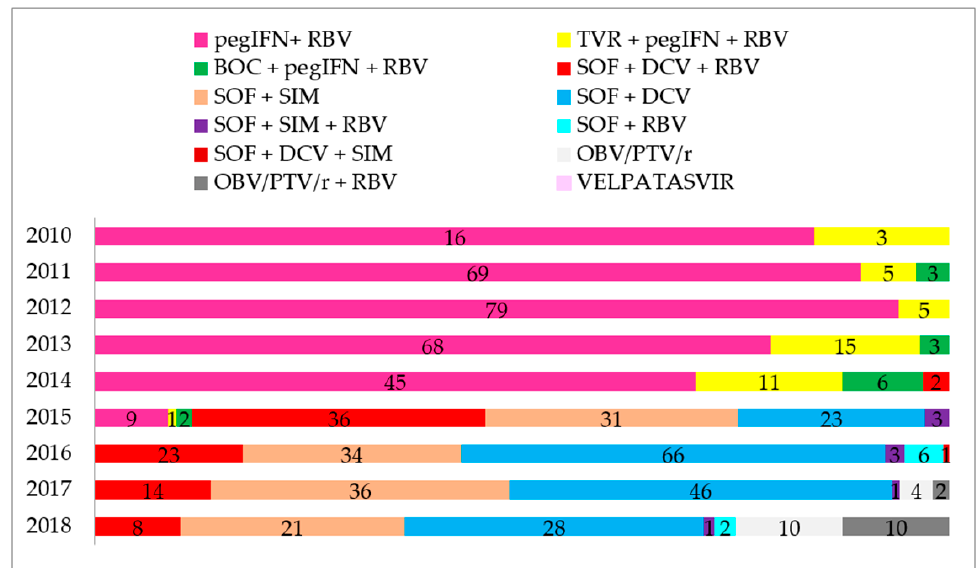
Figure 2. Evolution of HCV therapeutic regimens in a reference center in RHAN11 mesoregion located in Presidente Prudente, São Paulo, Brazil. BOC, boceprevir; DCV, daclatasvir; pegIFN, polyethylene glycol-interferon; RBV, ribavirin; SIM, simeprevir; SOF, sofosbuvir; TVR, telaprevir; OBV, ombitasvir; PTV, paritaprevir; r, ritonavir.